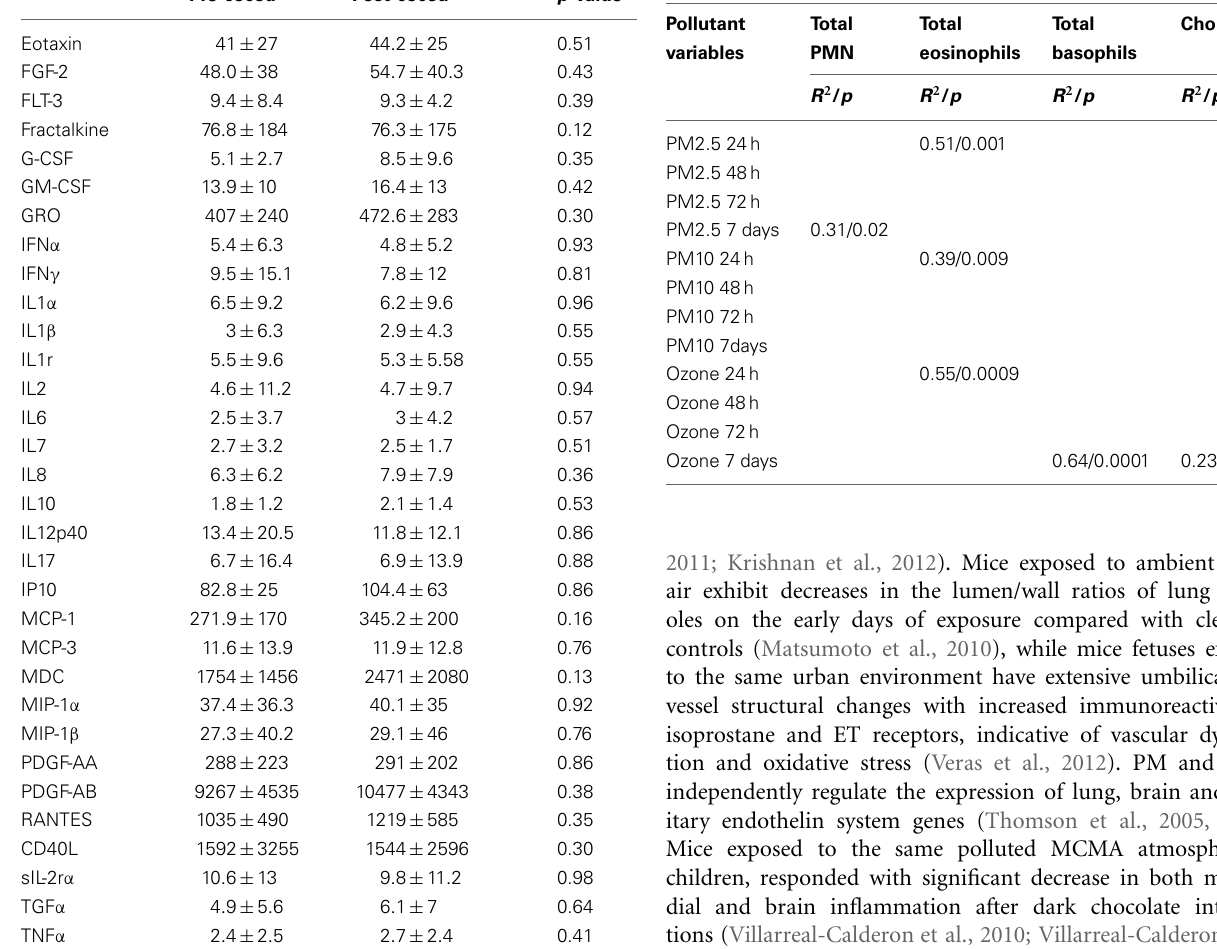
Table 3 | Inflammatory mediator and ET-1 results pre and post-cocoa intervention.